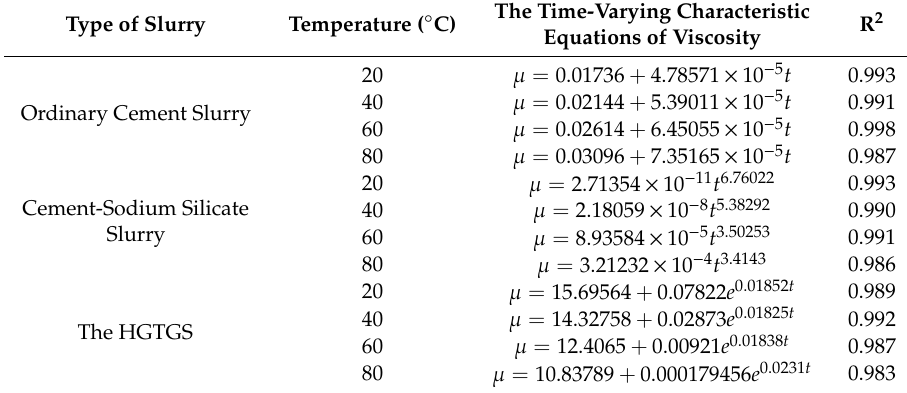
Table 6. The time-varying characteristic equations of viscosity of three kinds of slurries in di ff erent temperature conditions.